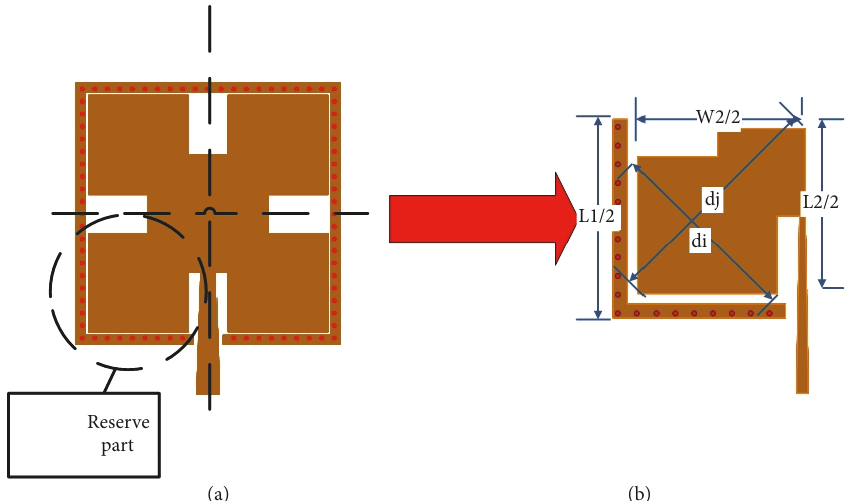
Figure 4: Process of the evolution of the proposed quarter-mode: (a) layout of full-mode; (b) layout of quarter-mode.